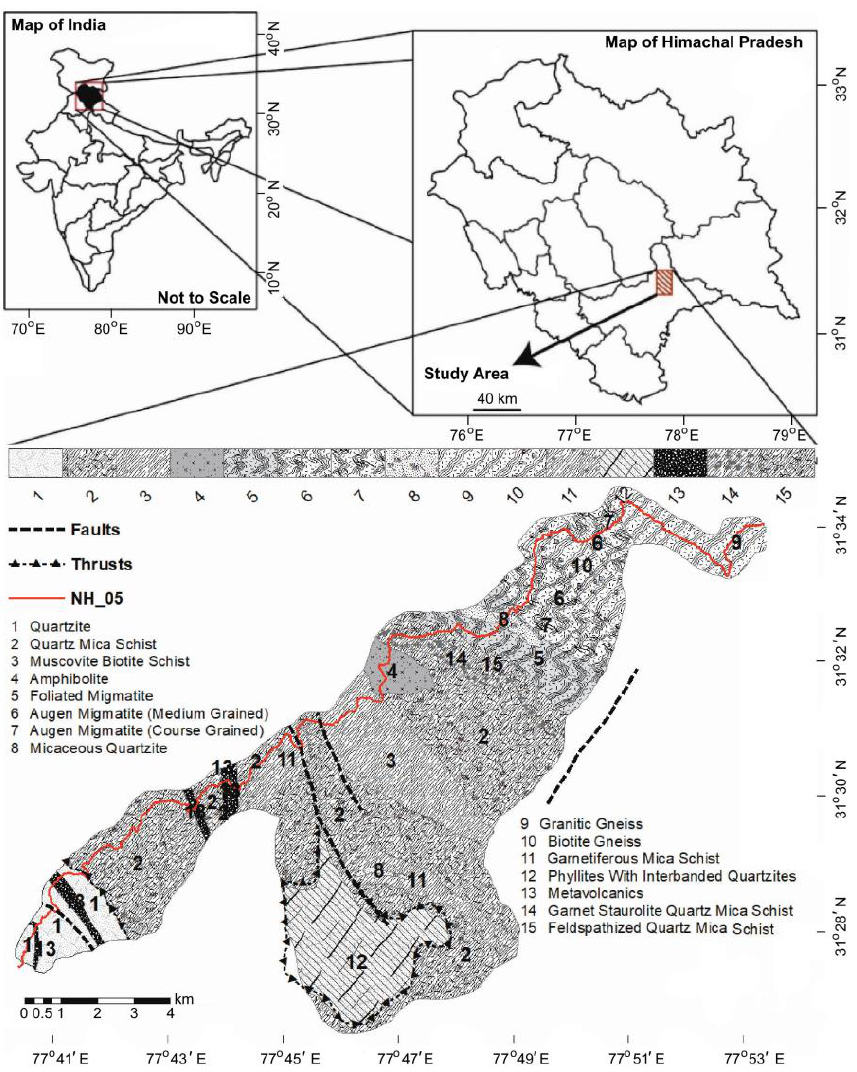
Figure 2. Geological map of the study area.